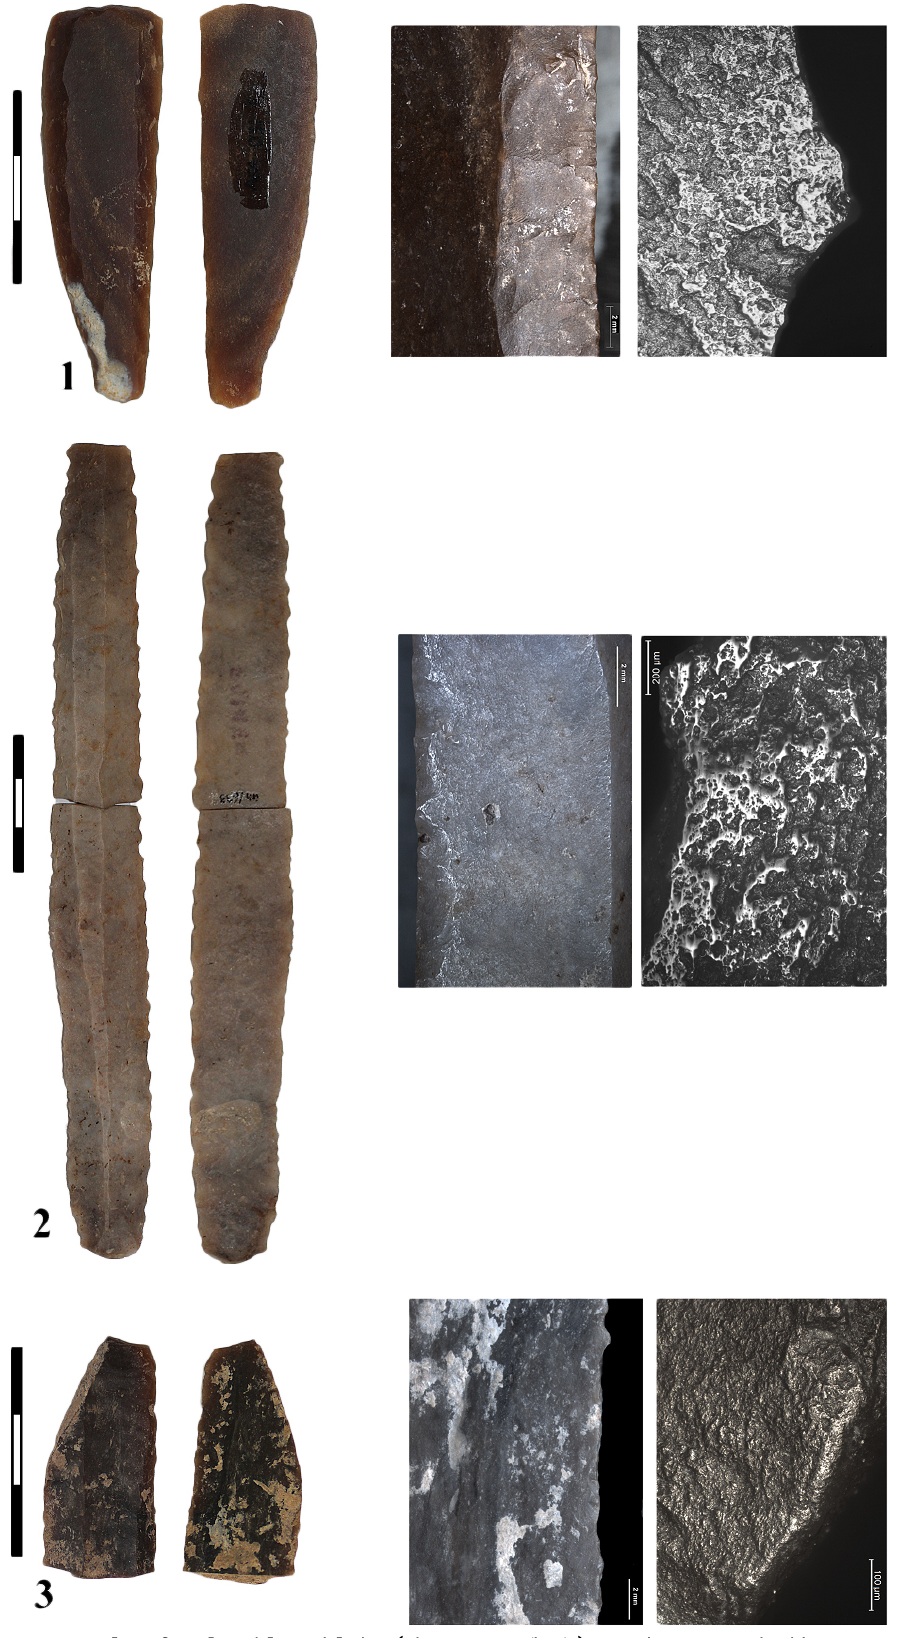
Figure 9. Three examples of analysed large blades (Photo J.F. Gibaja). Numbers 1 & 2 had been used for harvest the cereals or in latter works, number 3, have been used too in other works, as cutting meat and scraping hide or wood. Scale bars = 3 cm (in 1 cm